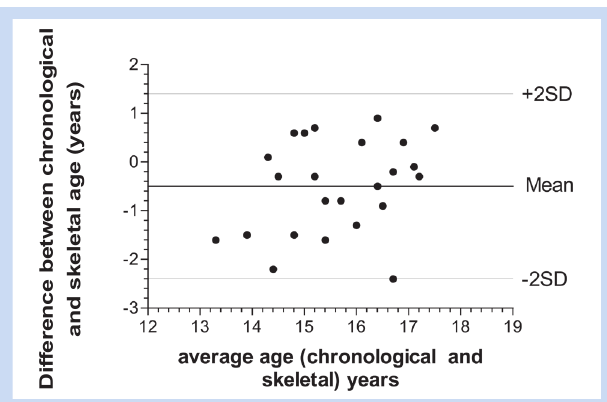
Fig. 2. The Bland-Altman plot 11 for chronological and skeletal age. The limits of agreement were -2.4 to 1.4 years (negative differences mean that chronological age was